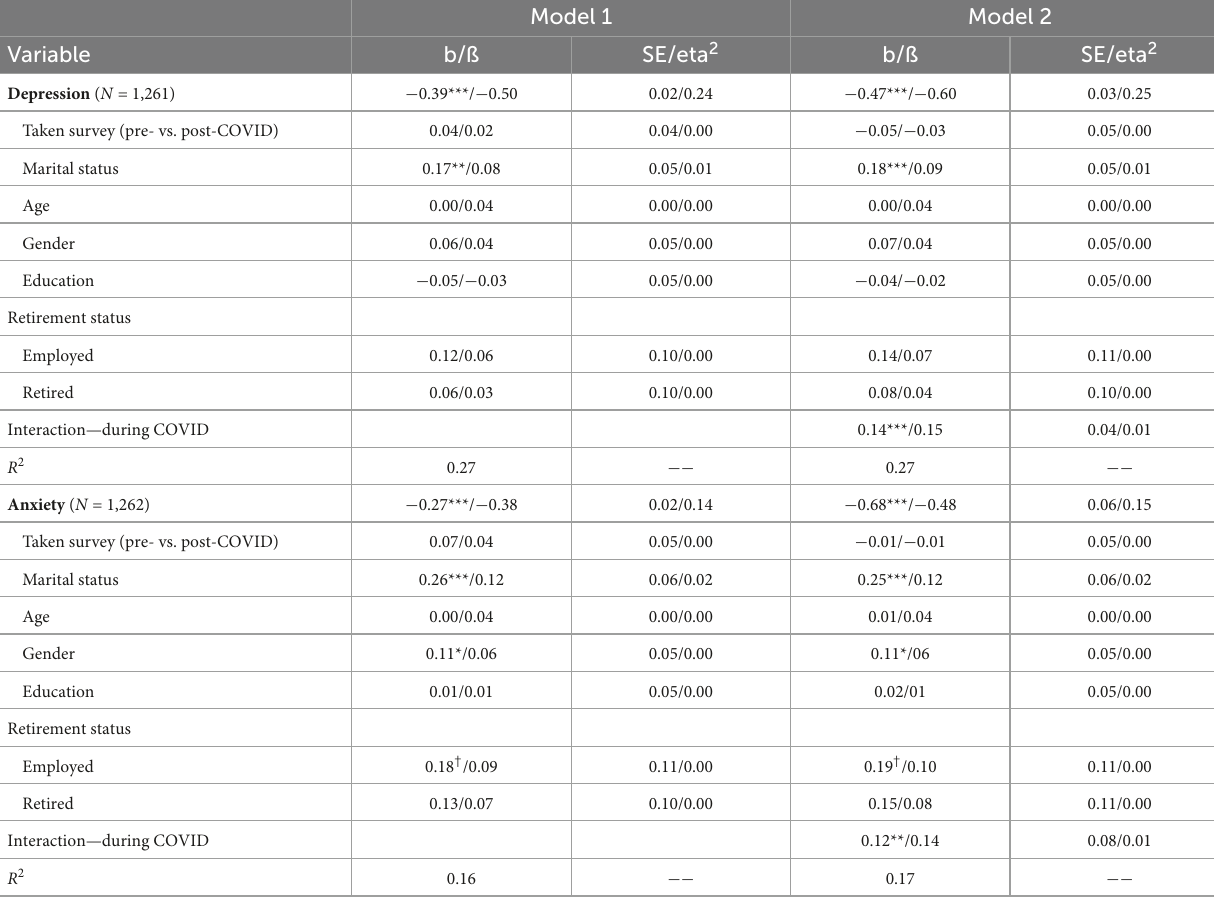
TABLE 3 Regression coefficients of depression and anxiety symptoms predicting happiness in older adults, study